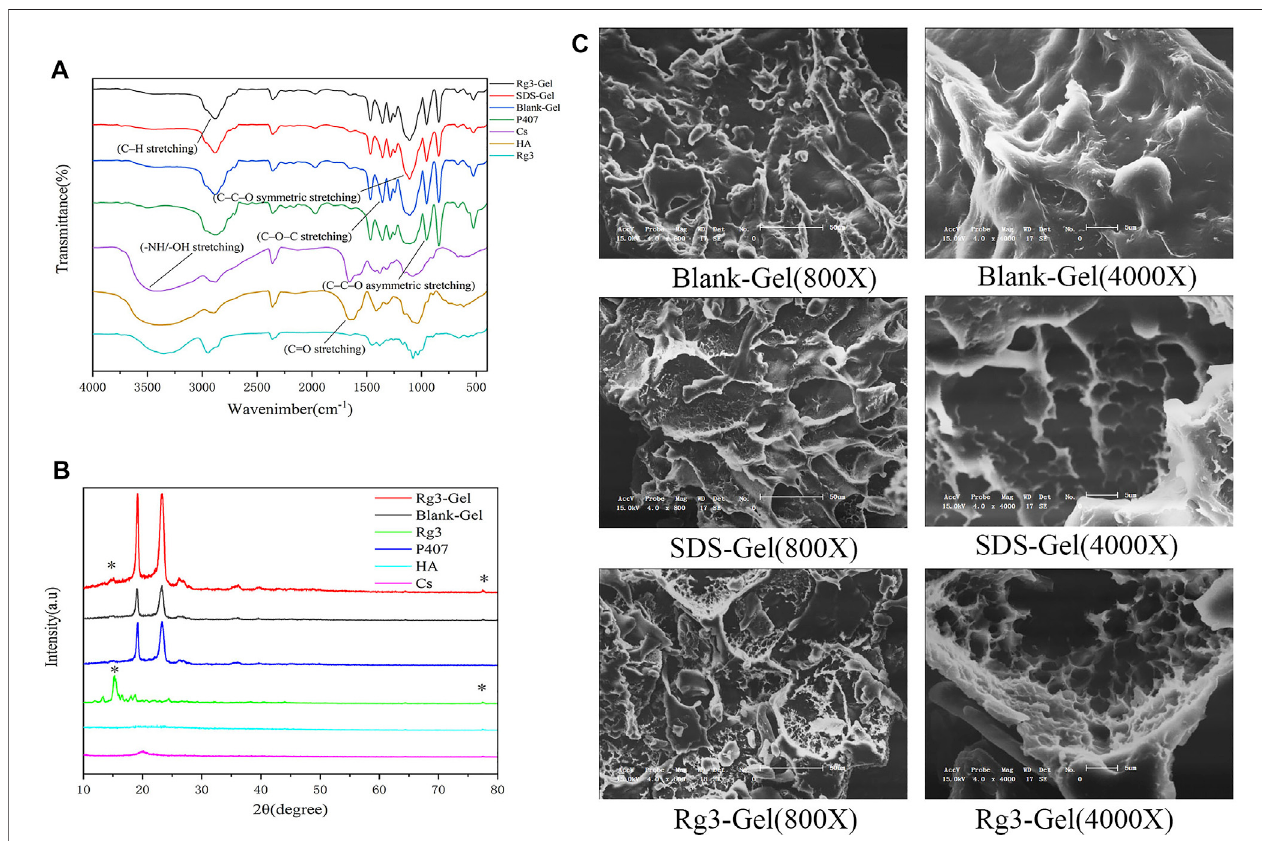
FIGURE1| StructuralcharacteristicsoftheRg3-Gel. (A) FouriertransforminfraredspectraofRg3,neatP407,Cs,HA,Blank-Gel,SDS-Gel,andRg3-Gel. (B) XRD pattern of Rg3, neat P407, Cs, HA, Blank-Gel, and Rg3-Gel. (C) SEM images of freeze-dried Blank-Gel, SDS-Gel, and Rg3-Gel samples (X800 & X4000).